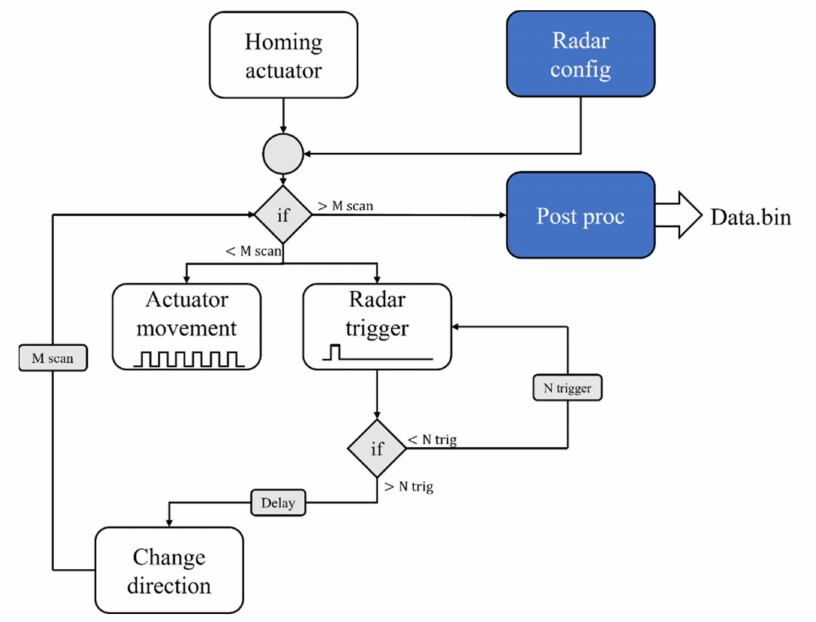
Figure 2. Flow chart of acquisition system of W-band GB-SAR.